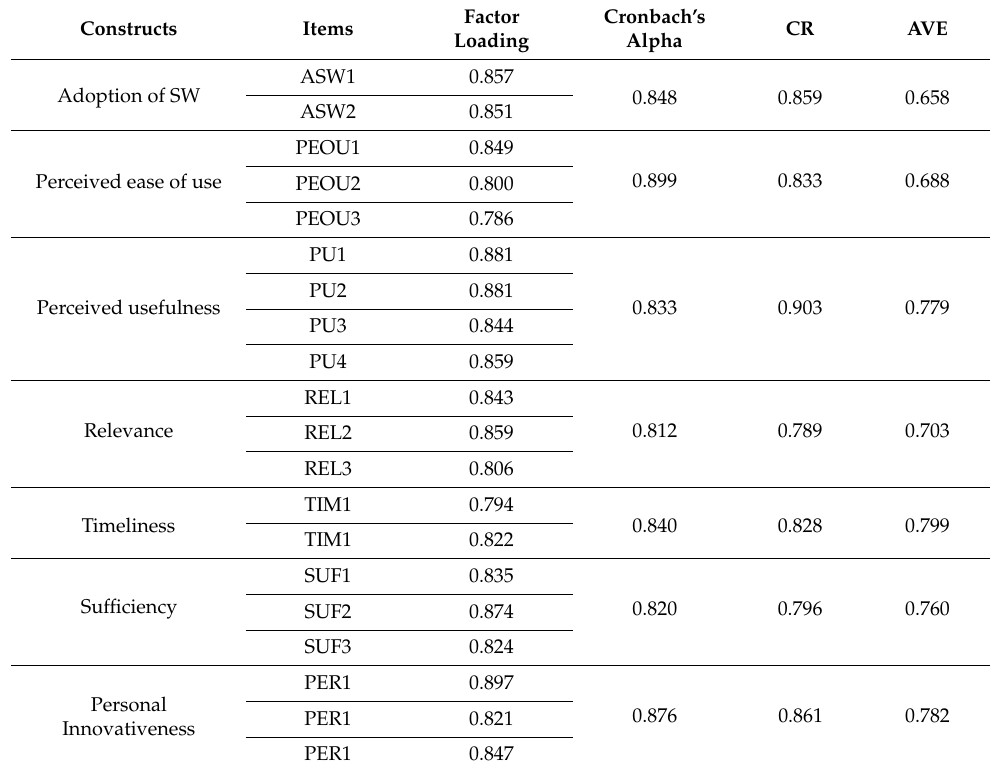
Table 5. Convergent validity results which assure acceptable values (Factor loading, Cronbach’s Alpha, composite reliability ≥ 0.70 & AVE >